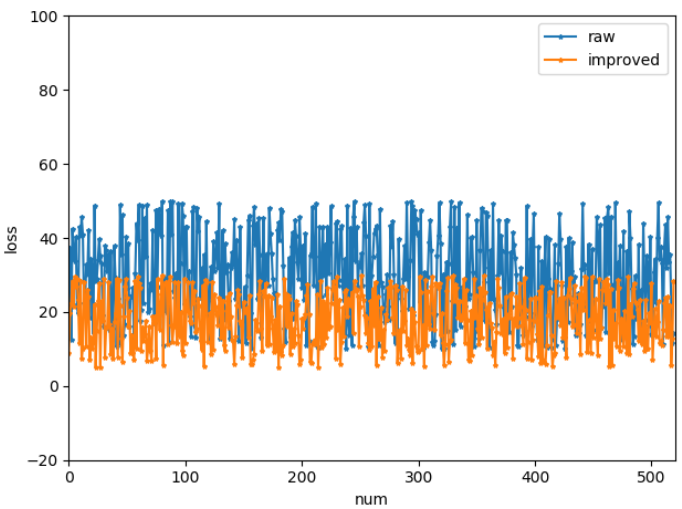
Figure 19. Comparison of the initial radar data and the algorithm error of this paper.